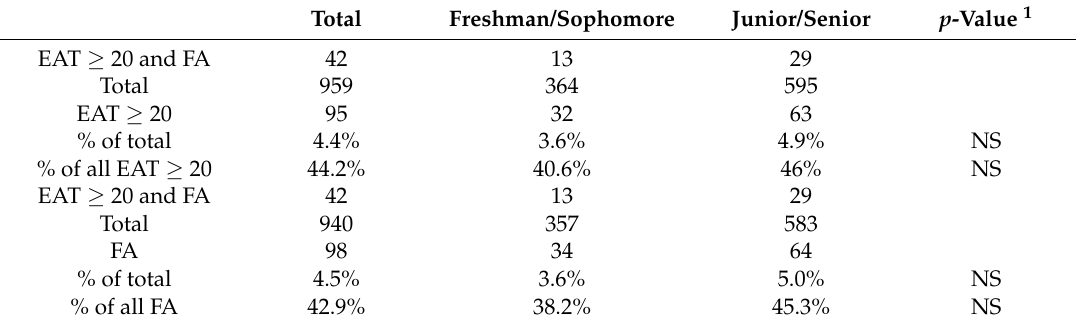
Table 6. Co-occurrence of EAT Score ≥ 20 and food addiction (FA) diagnosis by academic